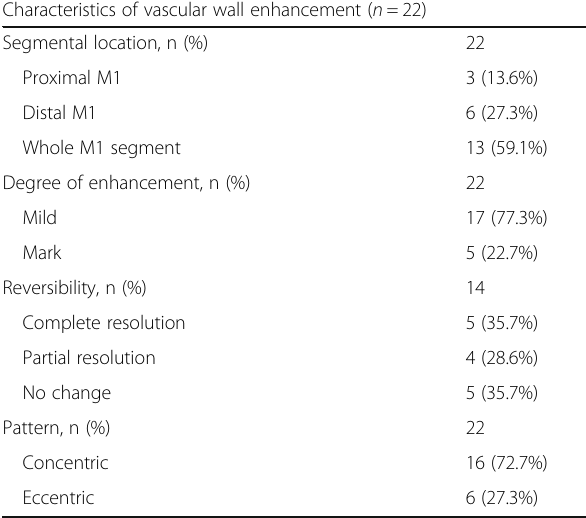
Table 1 Characteristics of vascular wall enhancement in patients with RCVS Characteristics of vascular wall enhancement ( n =